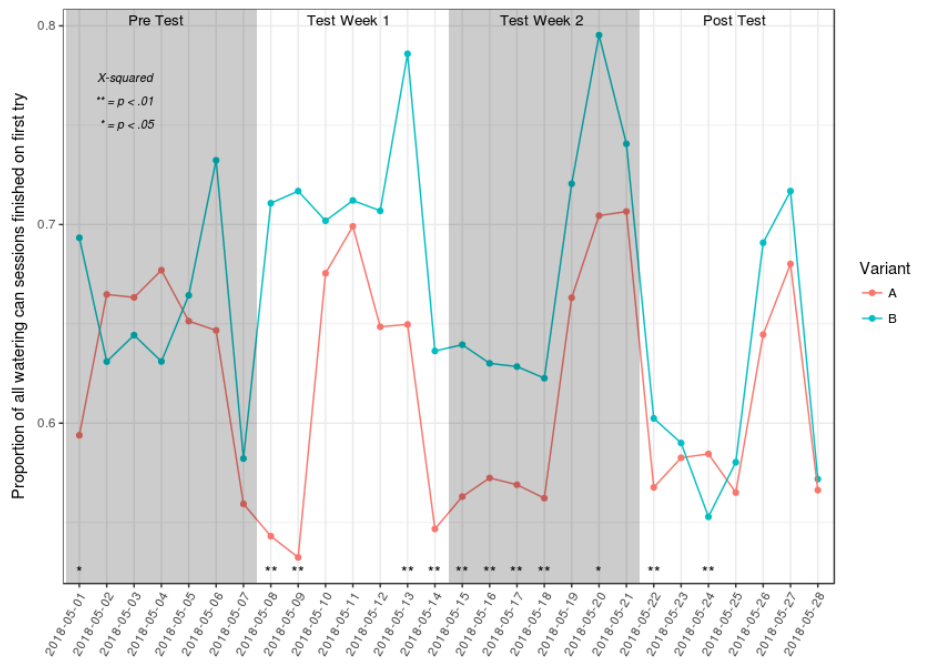
Figure 4. Di ff erences between finishing rates of the control (A) and treatment (B) condition over the length of the entire A / B